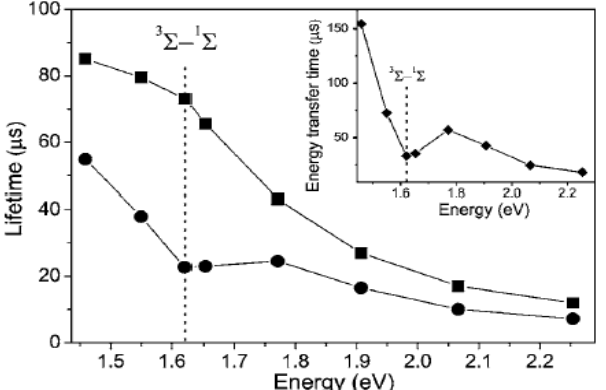
Figure 34. Spectral dependences of the PL lifetime measured for por-Si MPs dispersed in degassed water (squares) and in oxygen-saturated water (circles). Inset: spectral dependence of the energy transfer time in oxygen-saturated water. E exc = 2.33 eV, T = 300 K. (From Reference [91]).